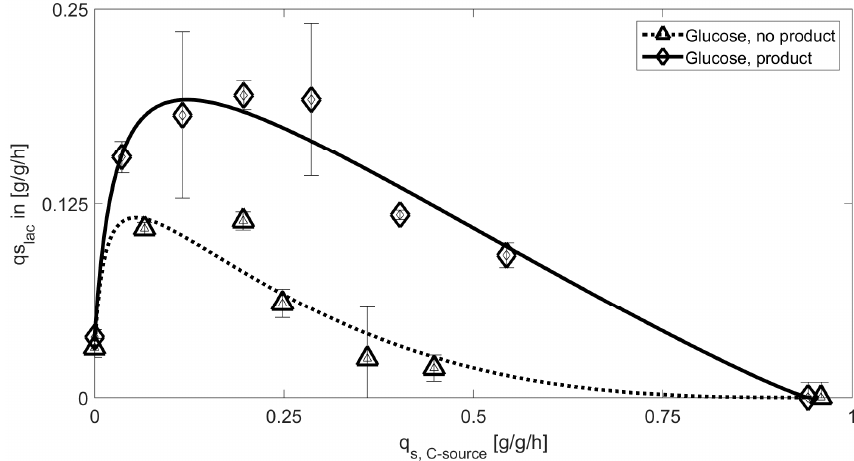
Figure 3 . Extracted datapoints for q s,C values including standard deviations for cultivations with glucose using the product producing (glucose product) and the NP strain (glucose, no product). Solid lines represent the model based approach for inducer uptake rates vs. feeding rates models of glucose. A clearly visible difference can be observed during these cultivations.